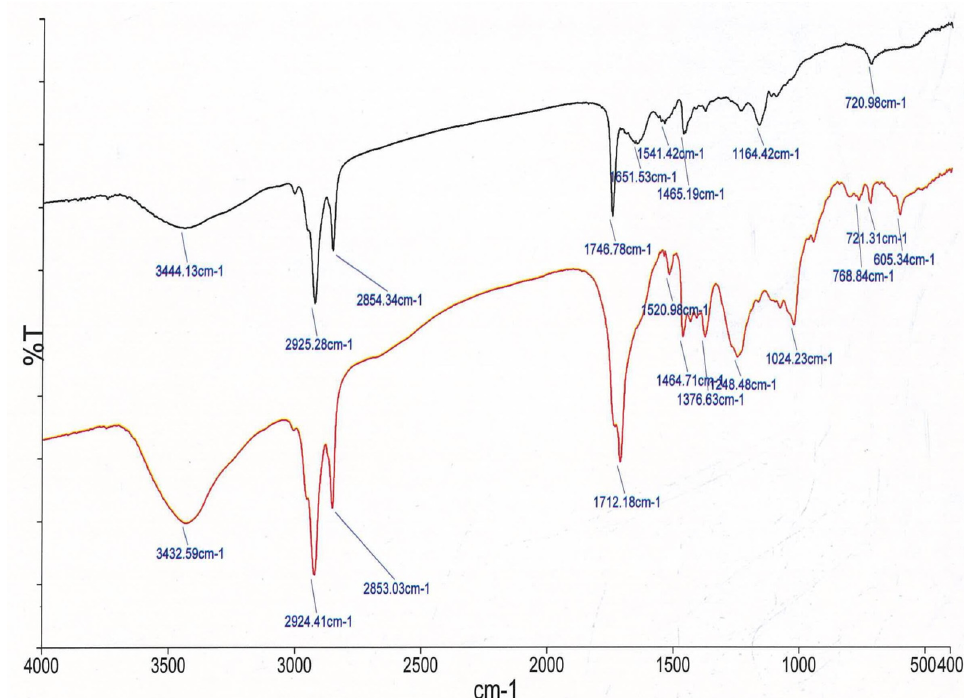
Figure 11. Comparative FTIR spectra between control skin and ethosomal gel-treated skin showing several peaks signify the molecular vibration of lipids and proteins present in the stratum corneum. (Red—Control skin, Black—Ethosomal gel treated skin).